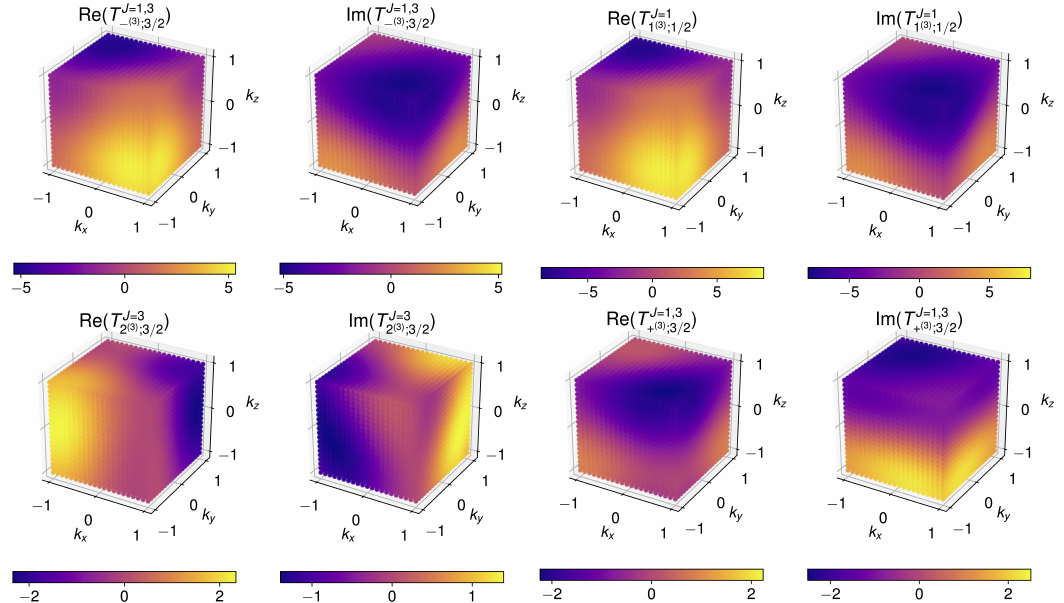
Figure 9: Momentum space distribution of the superconducting states ( j = 3 com- ponent) arising from the novel Kondo interaction presented in Table 2 and Fig.